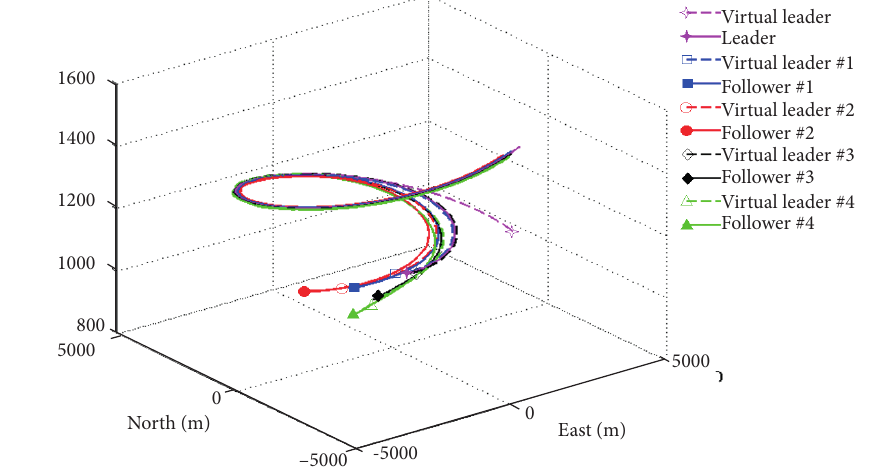
Figure 14. Maneuver motion in a spiral path.